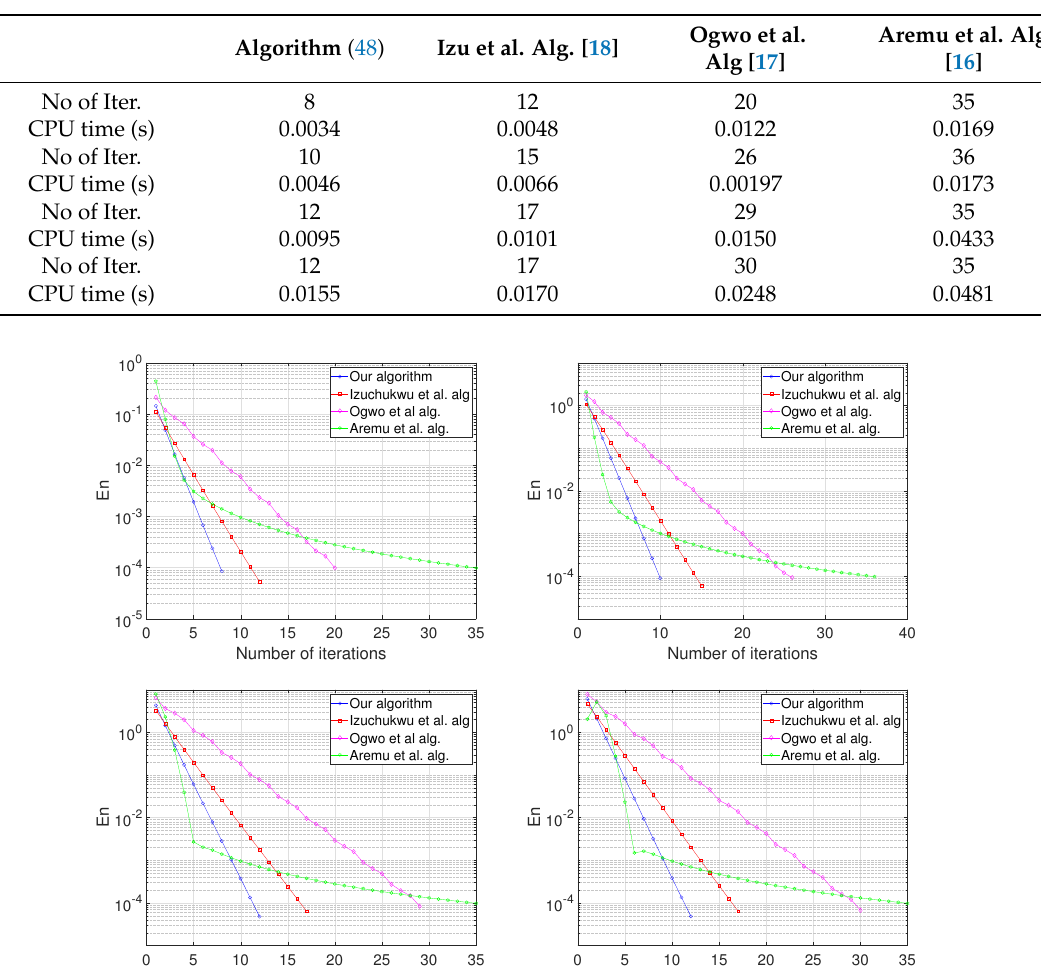
Table 1. Computation result for Example 1.